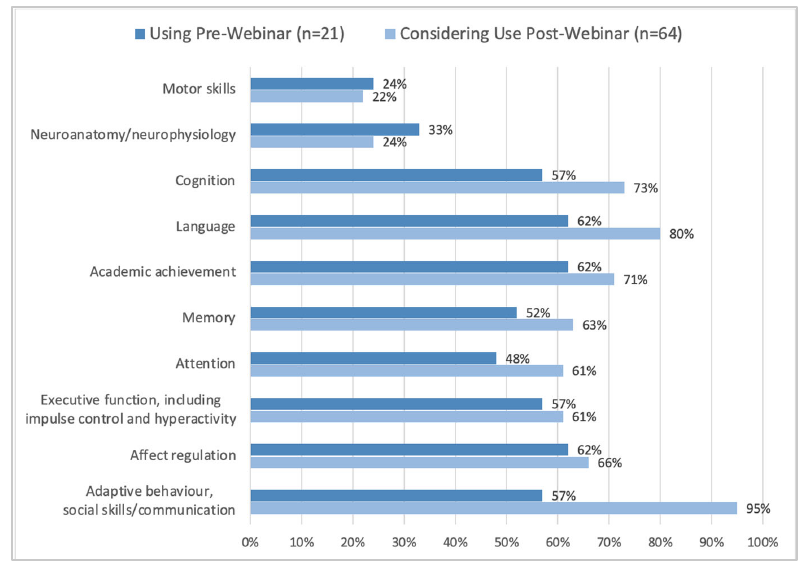
Figure 3. Parts of the neurodevelopmental assessments being used pre ‐ webinar and considered post ‐ webinar by the FASD diagnostic teams. post-webinar by the FASD diagnostic